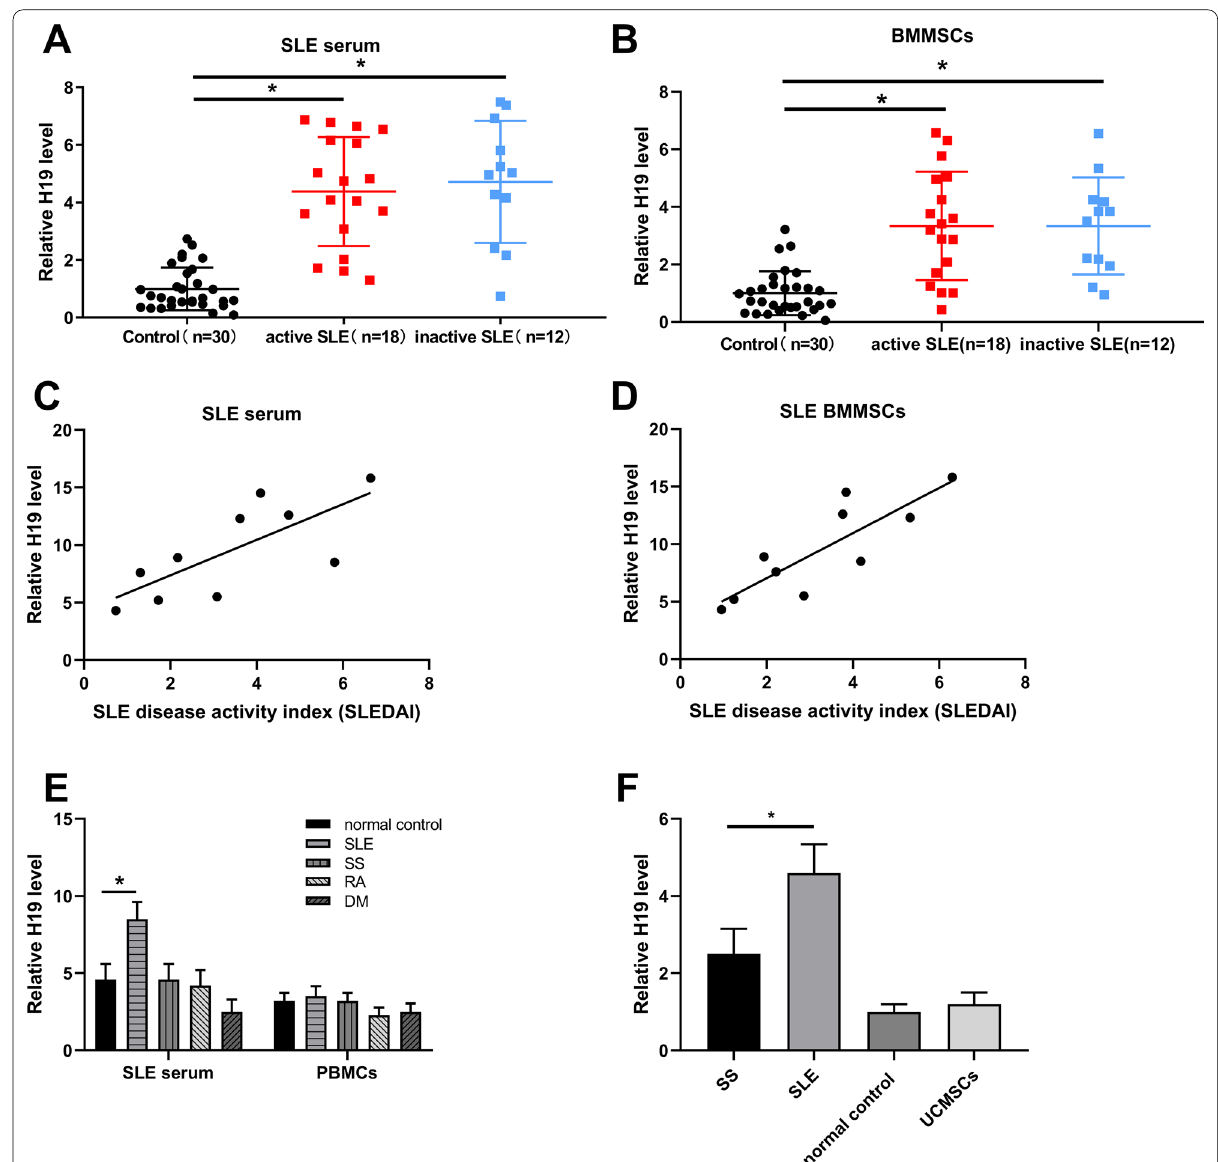
Fig. 1 LncRNA H19 was upregulated during SLE. A and B H19 mRNA level in the serum ( A ) and BMMSCs ( B ) of SLE patients (n 30) was detected = by RT-qPCR. C and D Association of H19 expression in serum ( C ) and BMMSCs ( D ) with SLEDAI score. E H19 mRNA level in serum and PBMCs from SLE patients (n 30), Sjögren’s syndrome (SS) patients (n 22), rheumatoid arthritis (RA) patients (n 9), dermatomyositis (DM) patients (n 9), and = = = = normal control was detected by RT-qPCR. F H19 mRNA level in BMMSCs from SS patients, SLE patients, normal controls, and umbilical cord-derived MSCs (UCMSCs) was detected by RT-qPCR. *P <